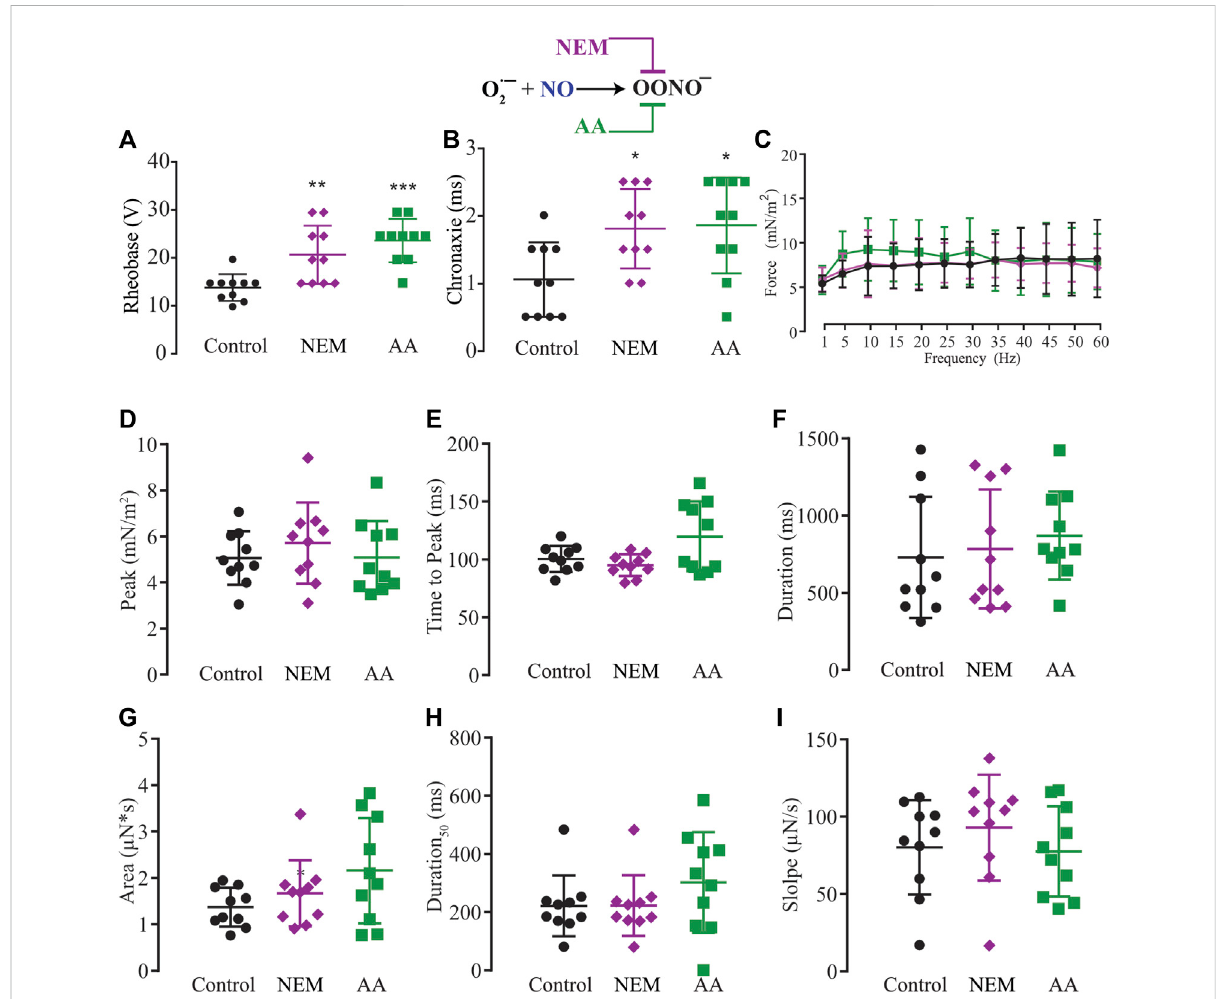
FIGURE 7 Summary of the effect of NEM and AA on the function of S-nitrosylation in myooid response to electrical stimulation. Myooids perfused with control solution are represented by the black color, violet for myooids treated with NEM, and green for those treated with AA. (A) rheobase and (B) chronaxie summarized the excitability of the myooids under subthreshold stimulation. (C) . Force frequency protocol. (D – I) analyses of the biophysicalparametersinresponsetosingle-twitchstimulation.Eachconditioncontainedtenmyooidsandthesymbols*,**,and***represent the signi fi cant thresholds below 5%, 1%, and 0.1%,